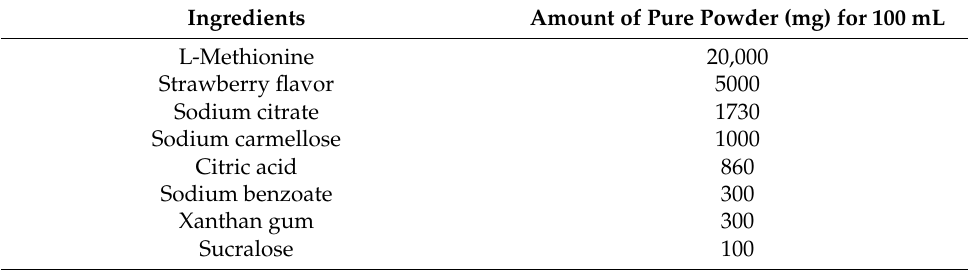
Table 1. Composition of Methionine formulation for oral suspension (200 mg/mL).